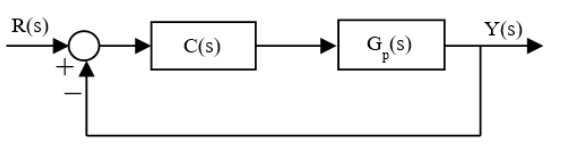
Figure 1. A S.I.S.O. control